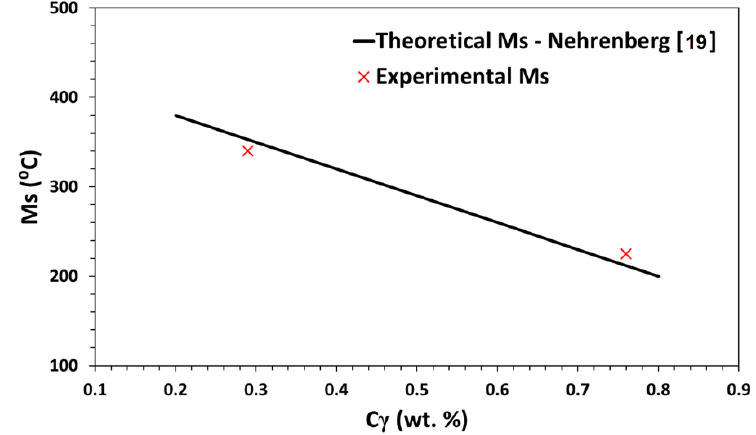
Figure 3. Theoretical Nehrenberg [19] and experimental Ms temperature as a function of carbon content in austenite, C γ .